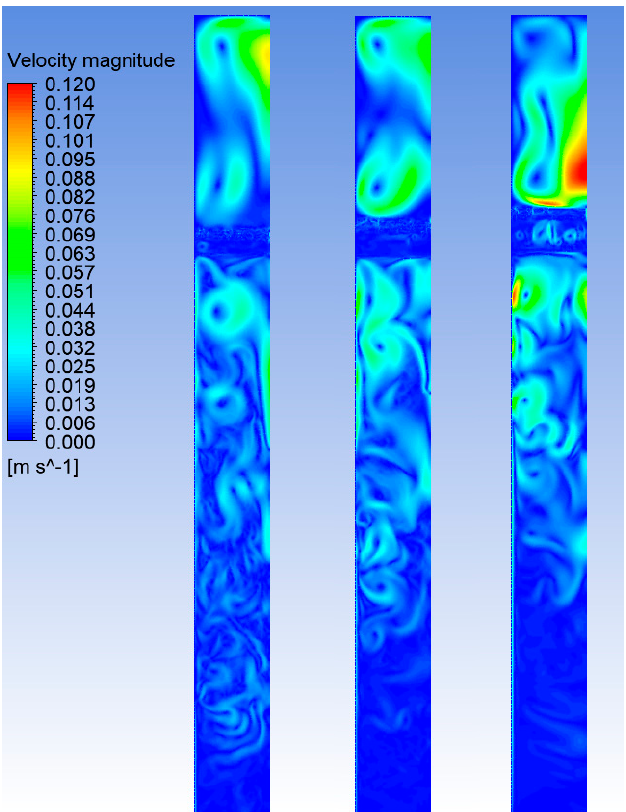
Figure 6 . Velocity fields within the reactor at different times, for the case of power input of 4.0 kW. Figure 6. Velocity fields within the reactor at di ff erent times, for the case of power input of 4.0 kW. From left to the right: 10, 20 and 30 min after the start of the process. From left to the right: 10, 20 and 30 min after the start of the